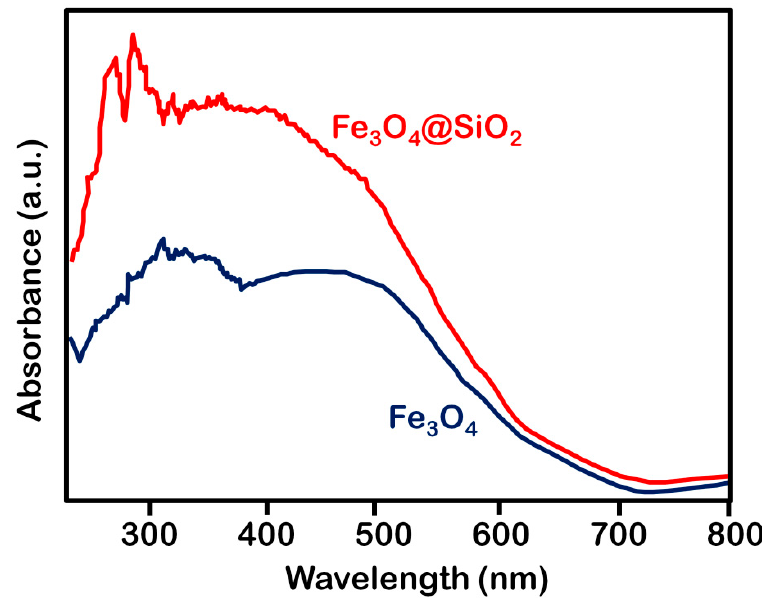
Figure 1. UV-Vis spectra of Fe 3 O 4 and Fe 3 O 4 @SiO 2 MNPs samples.